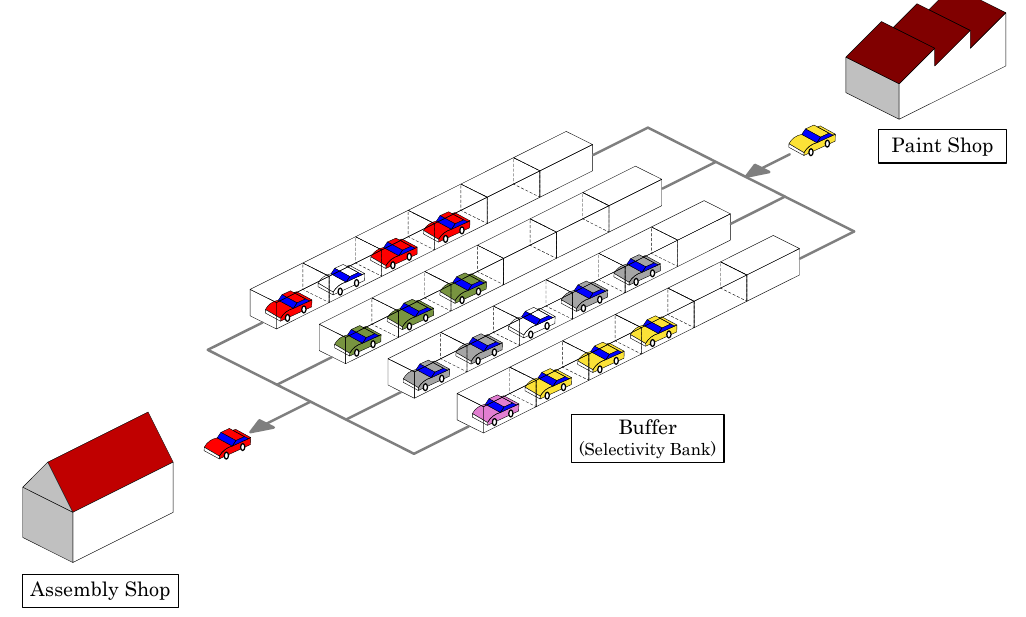
Figure 1. Illustration of a production system for automotive painting and